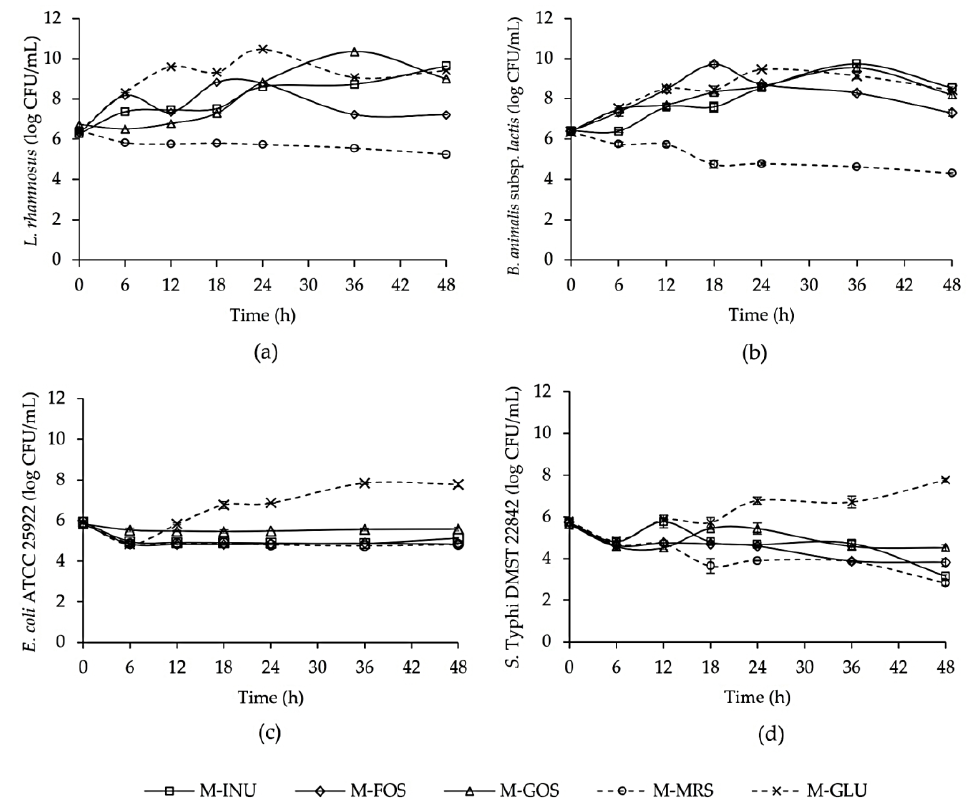
Figure 1. The growth kinetics of probiotics and pathogenic bacteria, ( a ) L. rhamnosus , ( b ) B. animalis subsp. lactis , ( c ) E. coli ATCC 25922, and ( d ) S . Typhi DMST 22842 in MRS medium and the different mediums supplemented with glucose (control) and prebiotics.